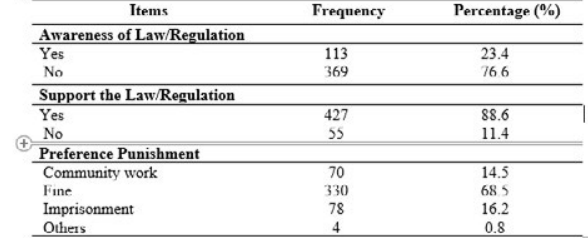
Table 4: Respondents’ Awareness of SWM Laws and Regulations